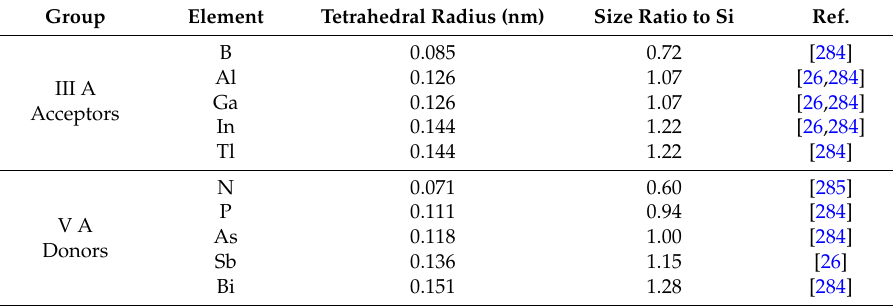
Table 19. Size of impurity atom relative to